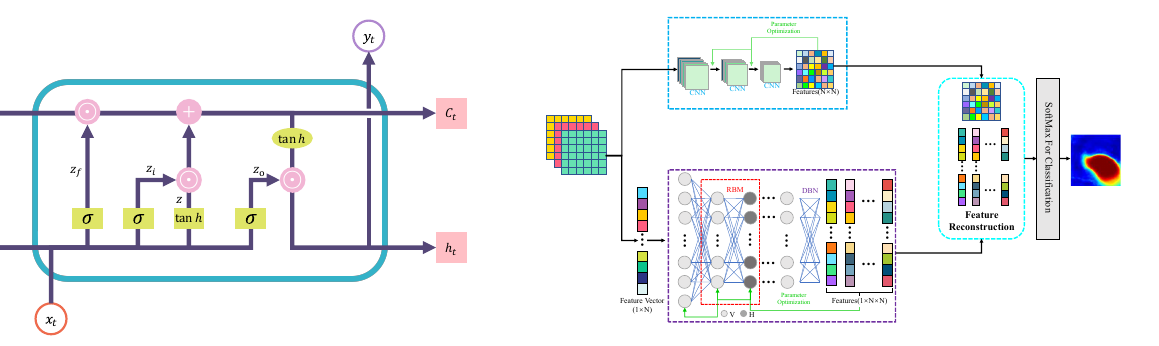
Figure 3. LSTM internal structure diagram.